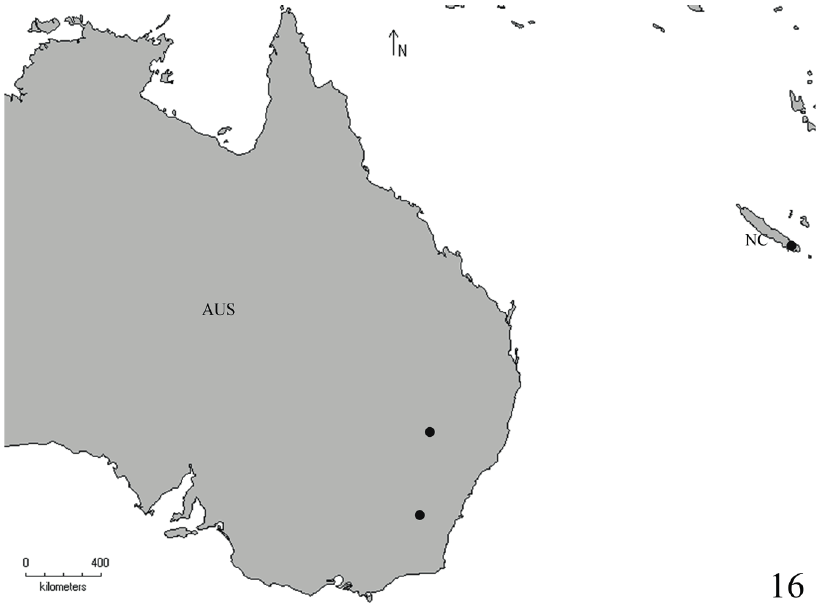
Figure 16 - Map of the known geographical distribution of Fannia capitalis Pont. legend. AUS = Australia; NC = New